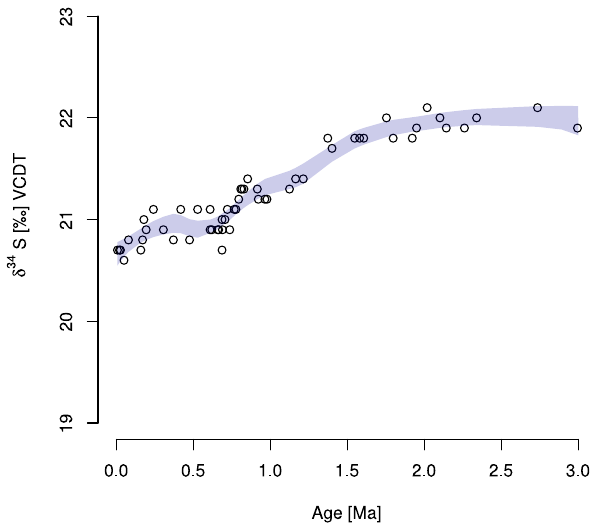
Figure 2. Seawater sulfate δ 34 S value. The circles denote the mea- sured seawater sulfate δ 34 S value, the shaded area the 95% con- fidence interval of a LOESS approximation of the “true” δ 34 S SO